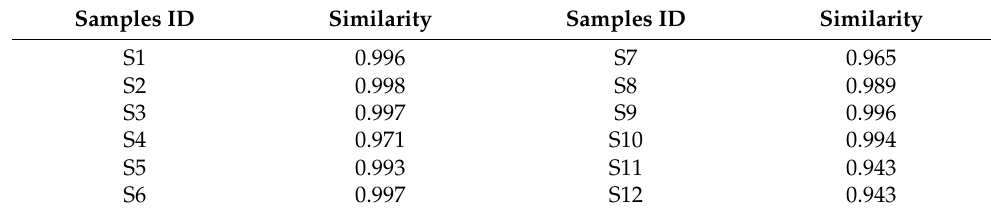
Table 3. The chromatographic similarities with GC–MS fingerprints for RCL and RHCL volatile oils.